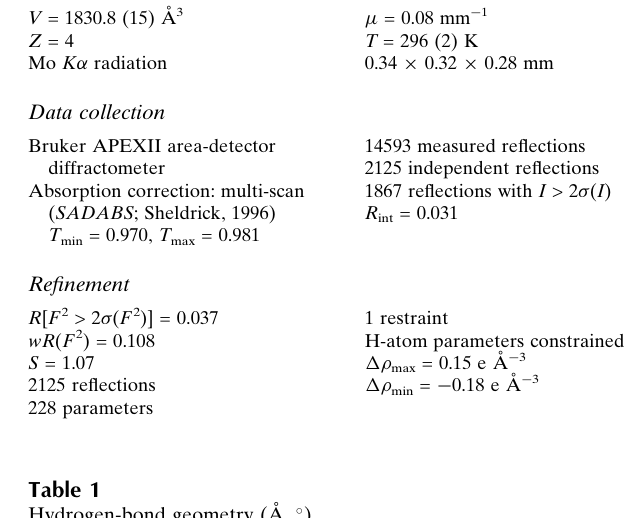
Hydrogen-bond geometry (A˚ , (cid:1)